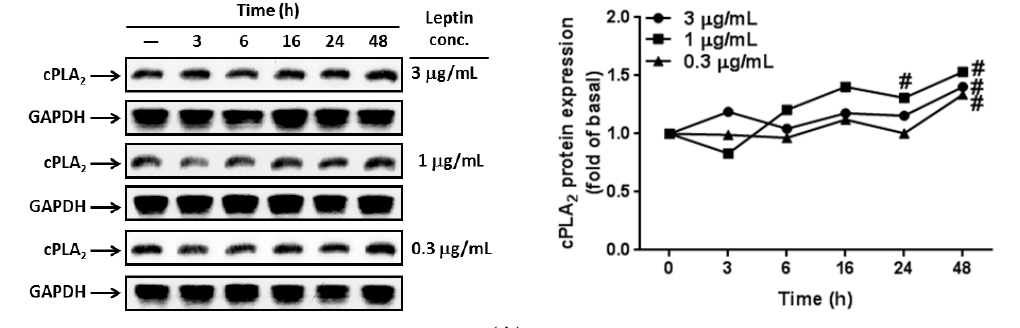
Figure 1. Cont. Figure 1. Cont .